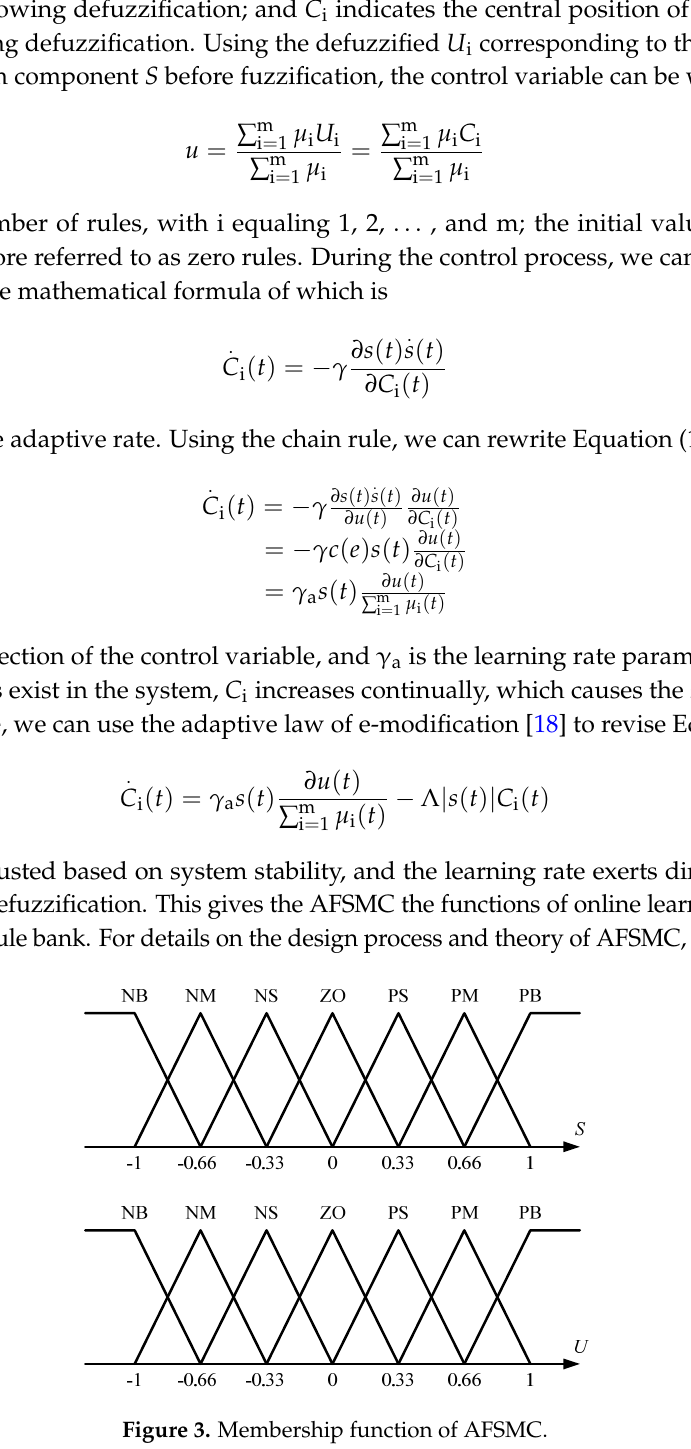
Figure 3. Membership function of AFSMC.